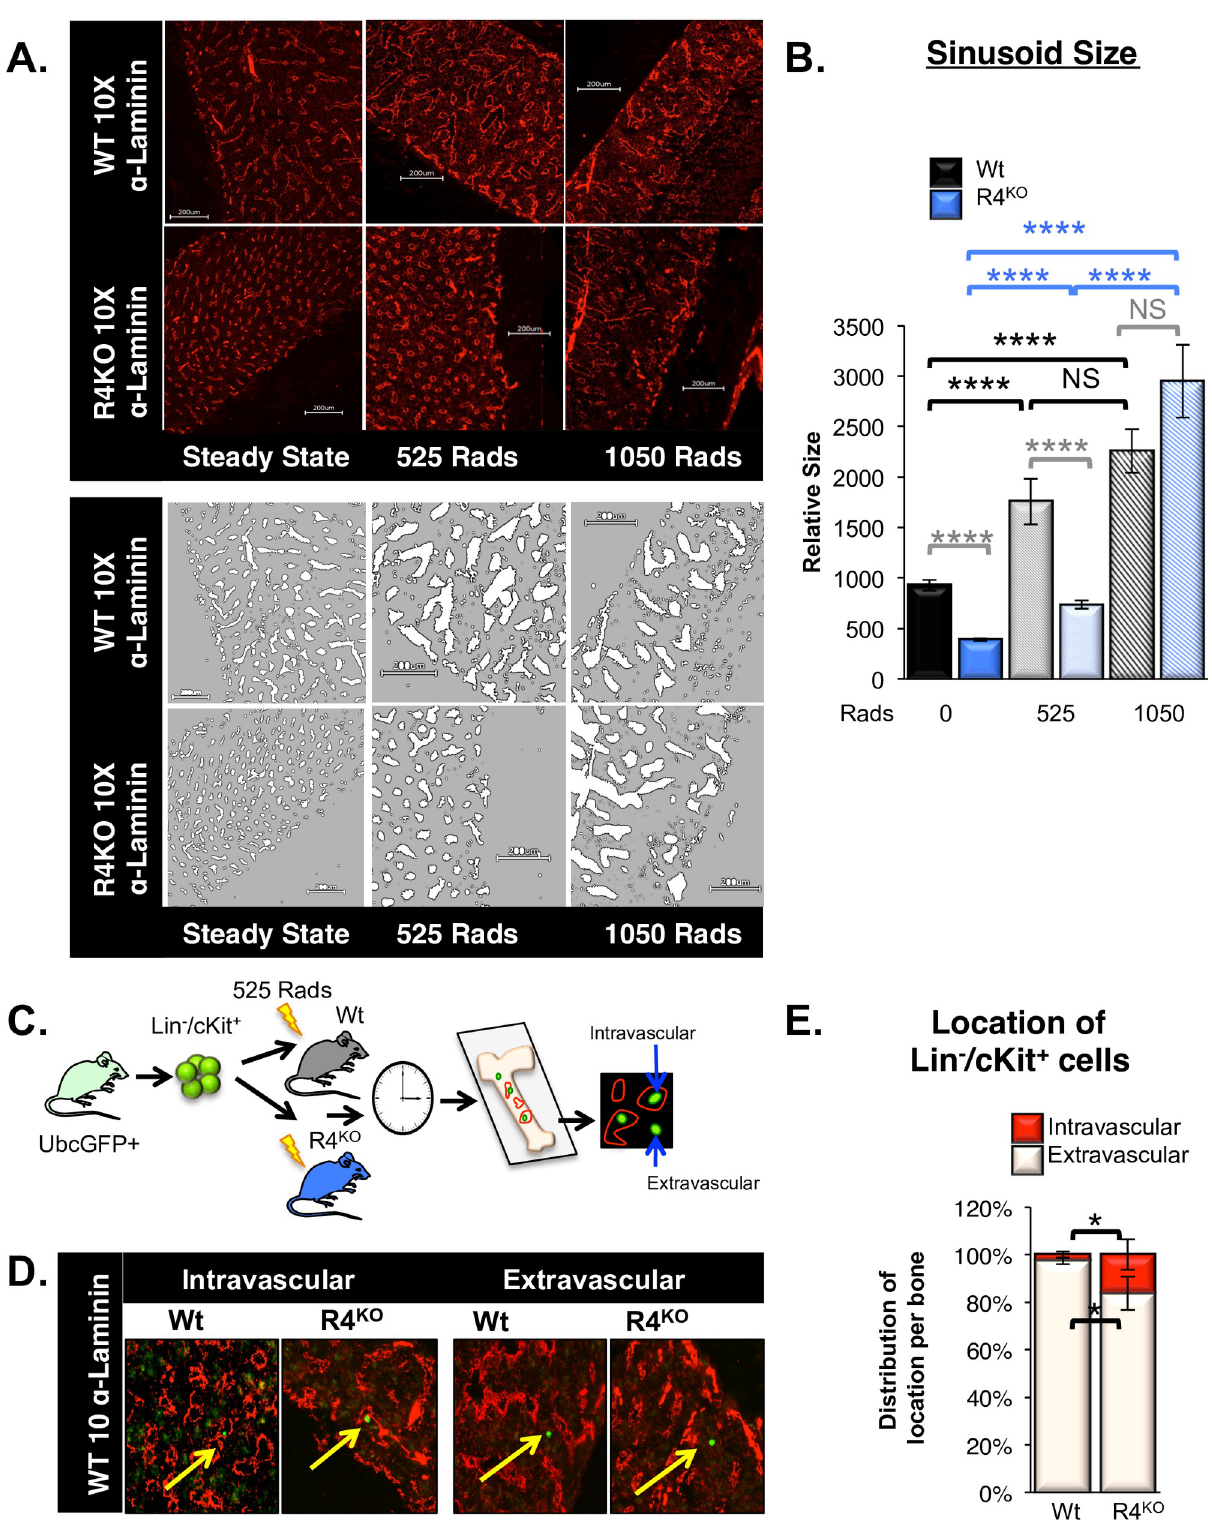
Fig 3. Increased radiation preconditioning further damages to the vascular bone marrow niche while donor HSC fail to extravasate in R4 KO hosts with non-myeloablative preconditioning. A. Increased radiation preconditioning caused enlarged BM sinusoidal structures and elimination of the differences between Wt and R4 KO mice. In Wt mouse BM sections, both 525 and 1050 rads resulted in enlarged sinusoidal structures. R4 KO sinusoids